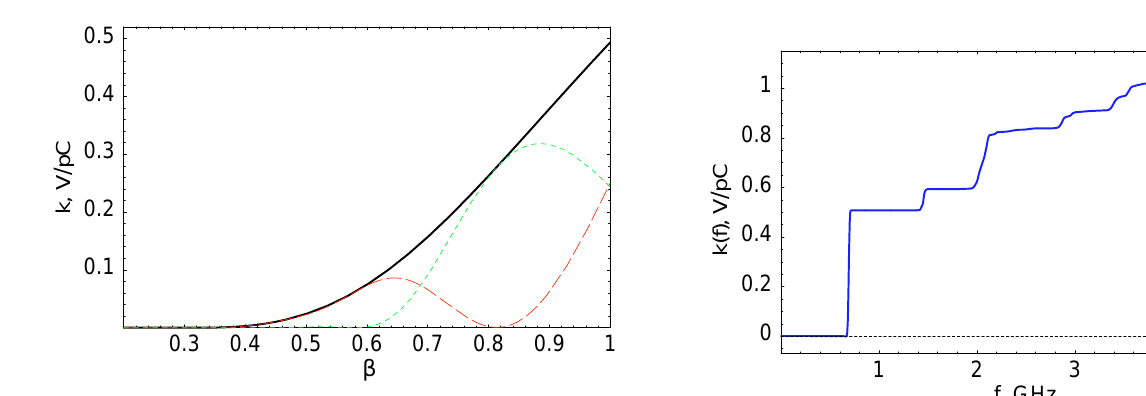
FIG. 6. (Color). The loss factor for all TM (cid:48)(cid:49)(cid:48) modes in the 5-cell APT b (cid:173) (cid:48)(cid:46)(cid:56)(cid:50) cavity versus b (solid line). The contribution of the accelerating ( p ) mode is plotted by the short-dashed line, and that of all others is plotted by the long- dashed line.